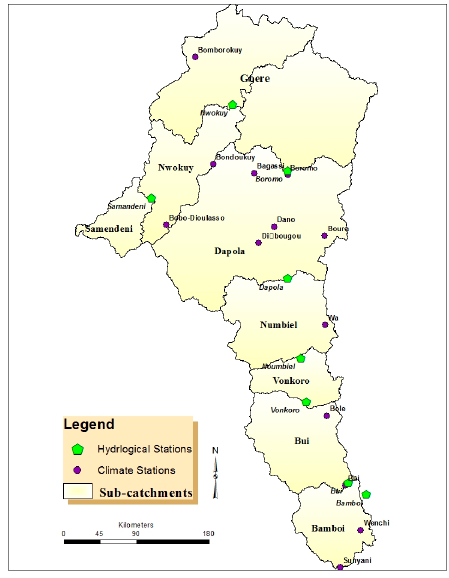
Figure 2. Different sub-catchments.